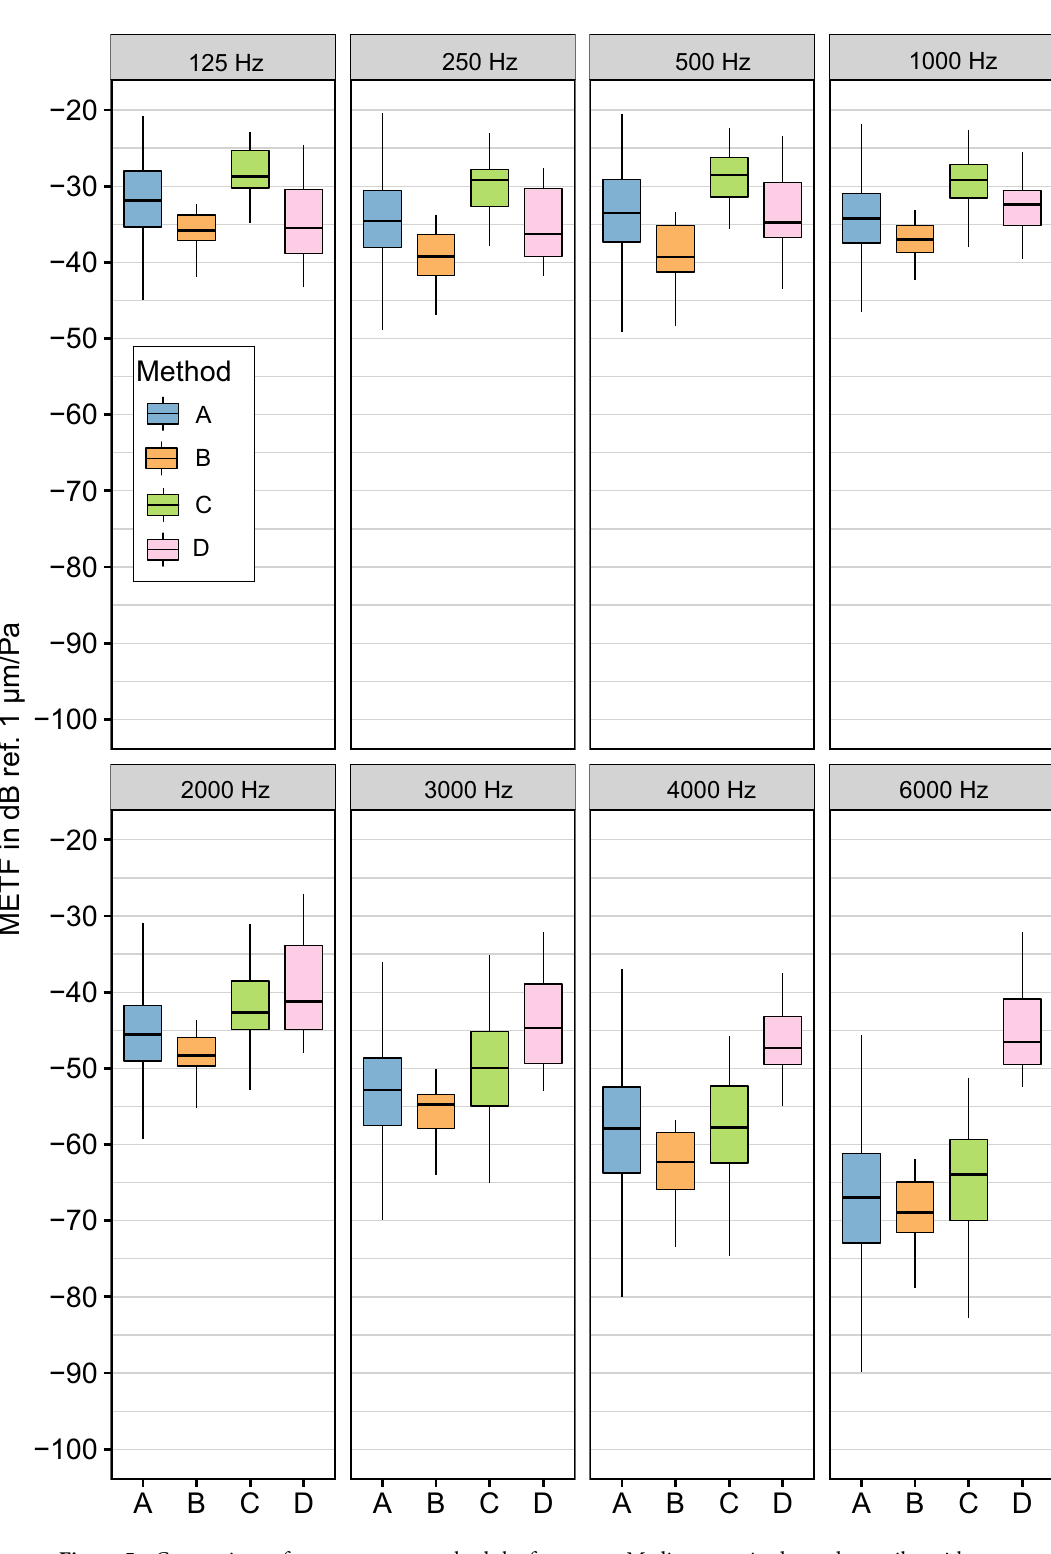
Figure 5. Comparison of measurement methods by frequency. Median magnitudes and quartiles without outliers are depicted. (A) single point LDV on footplate, (B) scanning LDV mean, (C) volume displacement calculated from scanning LDV data, (D) single point LDV on stapes head. Data for methods (A), (B) and (C) is from the same lab (Zürich), the data for method (D) is from another lab (Colorado). The data of